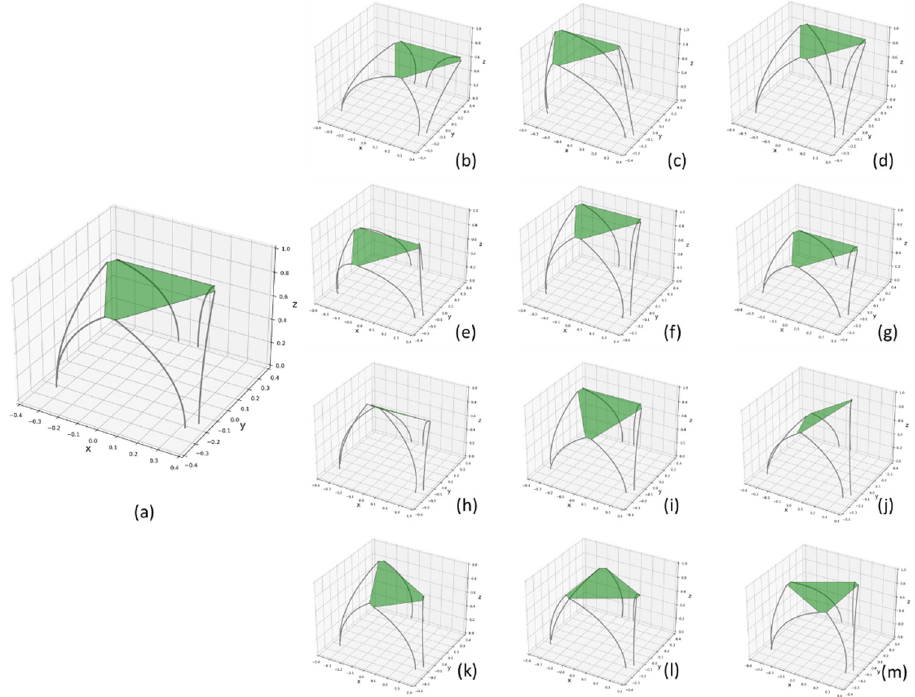
Figure 6. A 6-dof simulation for one flexible module. ( a ): initial orientation, ( b , c ): translation ±200 mm along x -axis, ( d , e ): translation ±200 mm along y -axis, ( f , g ): translation ±200 mm along z -axis, ( h , i ): rotation ±45° across x -axis, ( j ,k) rotation ±45° across y -axis, ( l , m ) rotation ±30° across z -axis.